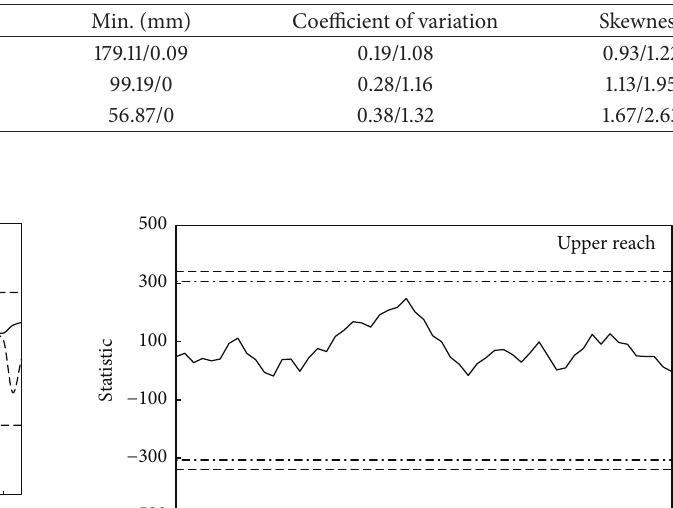
Table 1: The basic stochastic characteristics of annual/monthly precipitation in Heihe River basin.